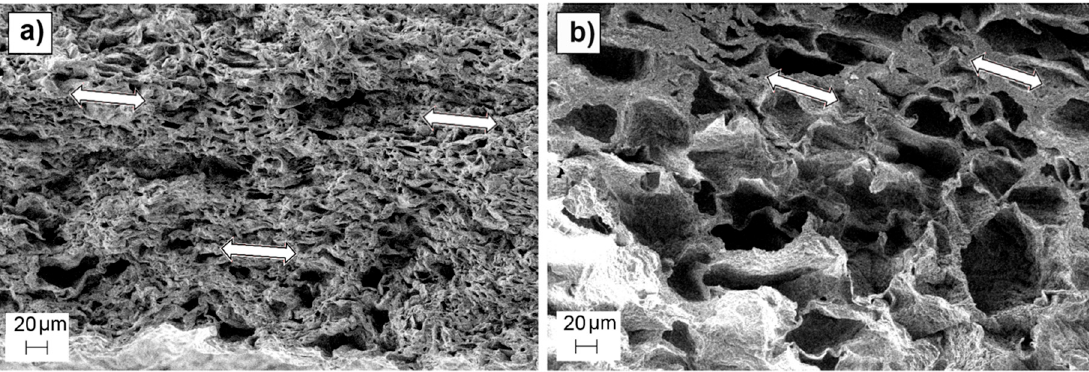
Figure 7. SEM images of cross-section surfaces of 005050 ( a ) and 501070 ( b ) sca ff olds, showing the observed directional pore deformation highlighted by white